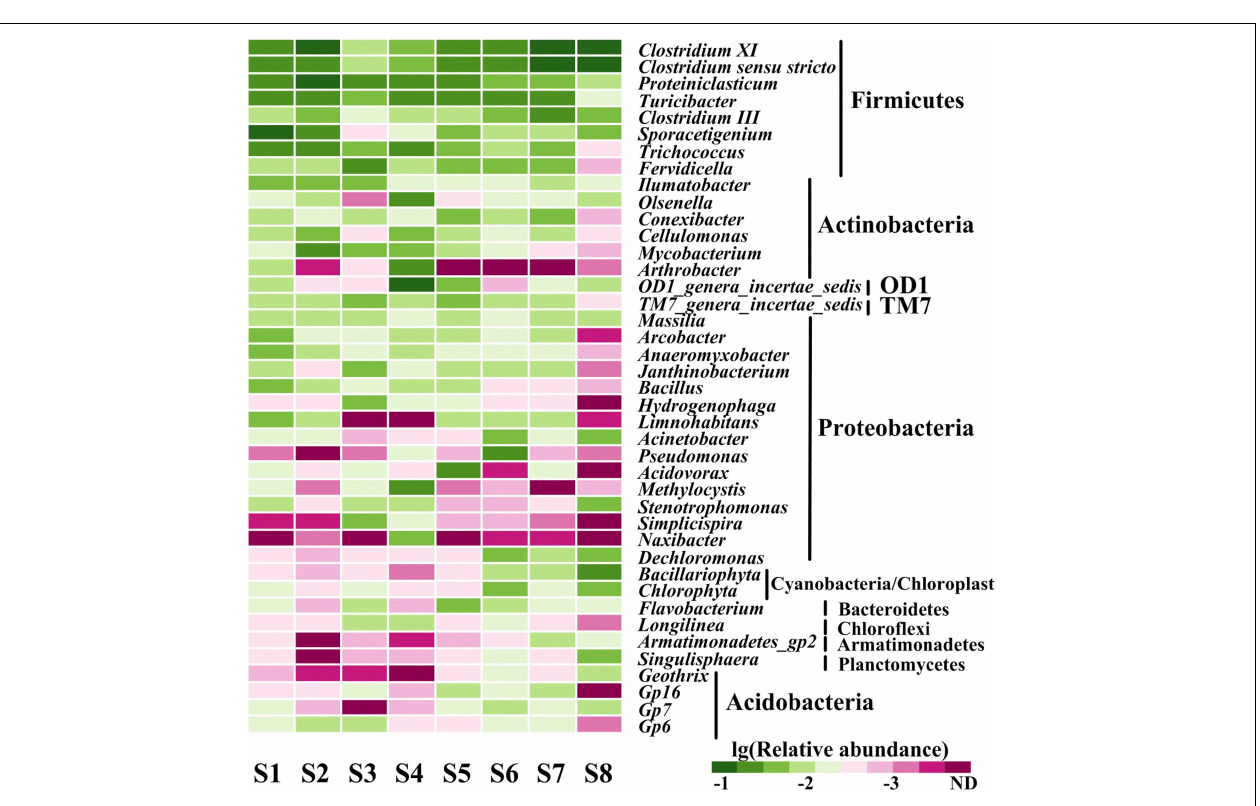
FIGURE 3 | Heat map of genera (occurred at > 1% at least one sample) in all sediment samples. The relative abundance was obtained by determined sequences vs. the total effective bacterial sequences with the help of RDP classifier at the threshold of